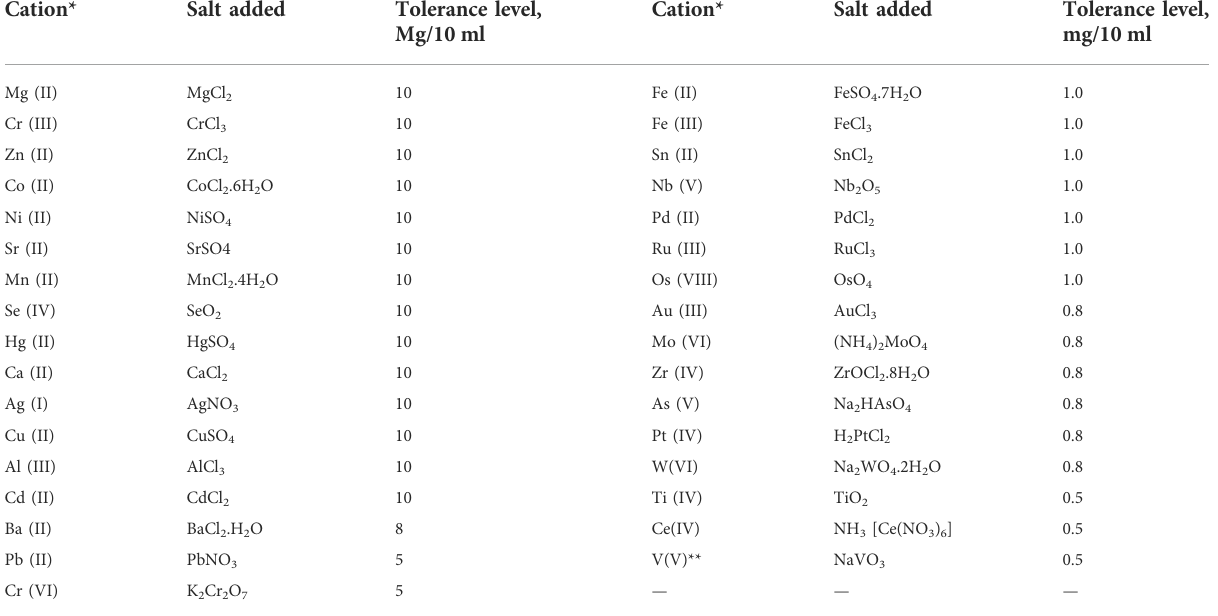
TABLE 3 Impact of cations on Ir (III)-CHMTB